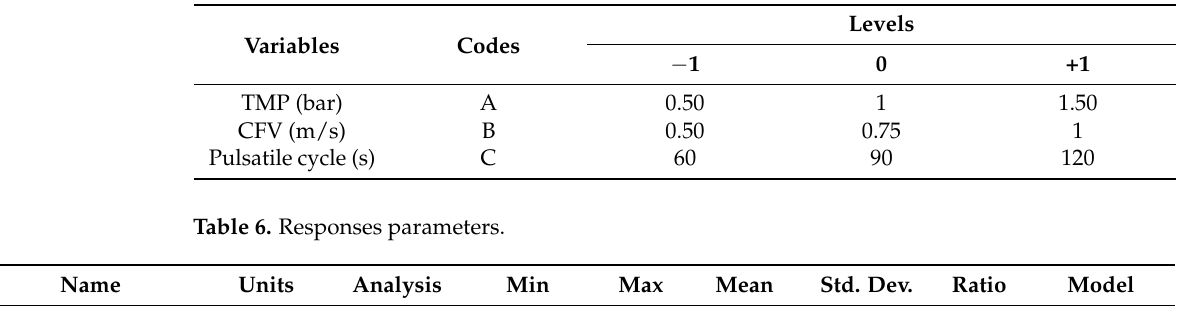
Table 5. Independent factors and their levels.